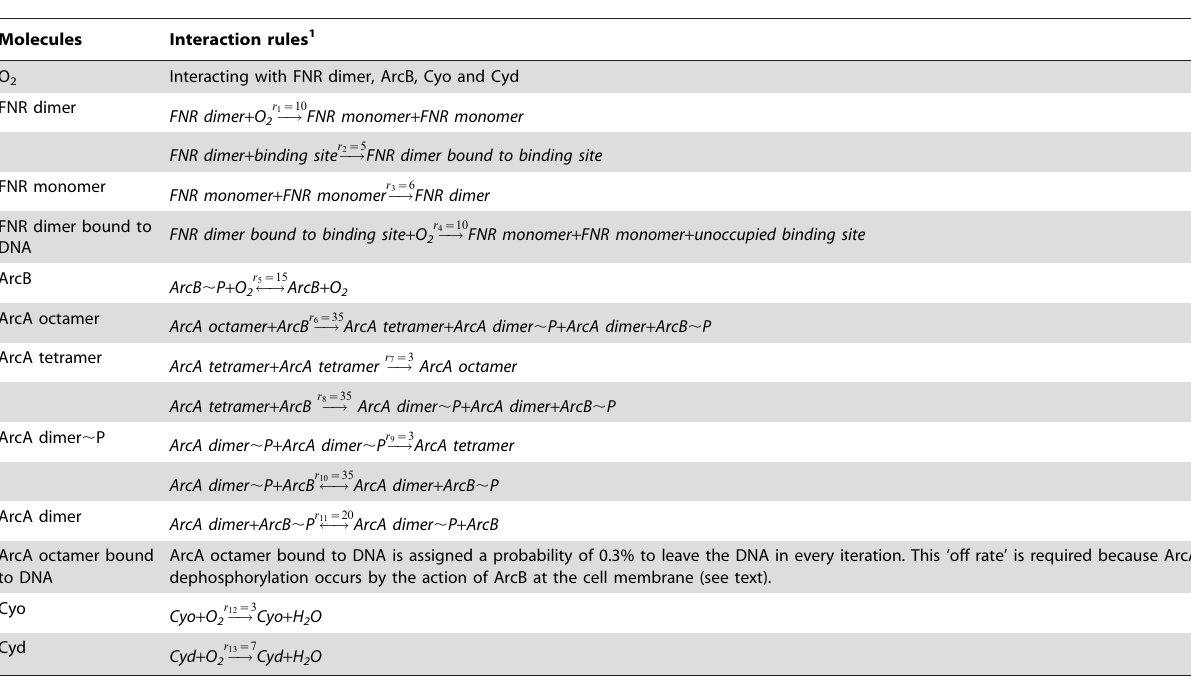
Table 2. Agent properties.